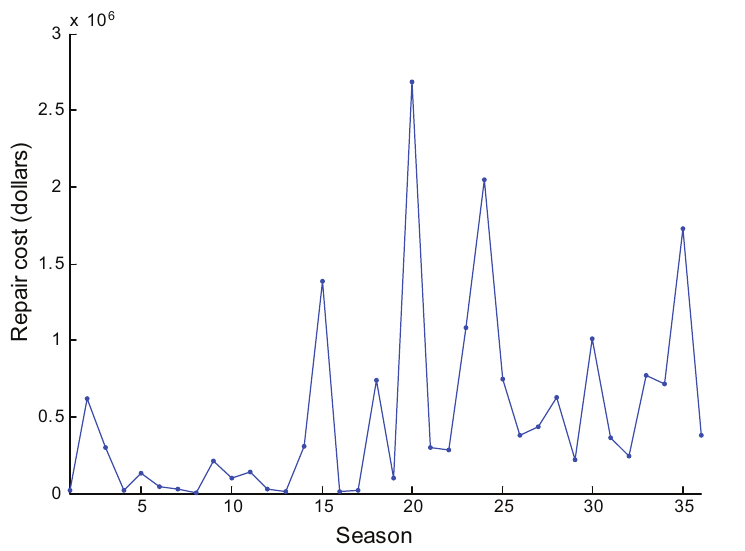
figure 4. repair cost of the east site building